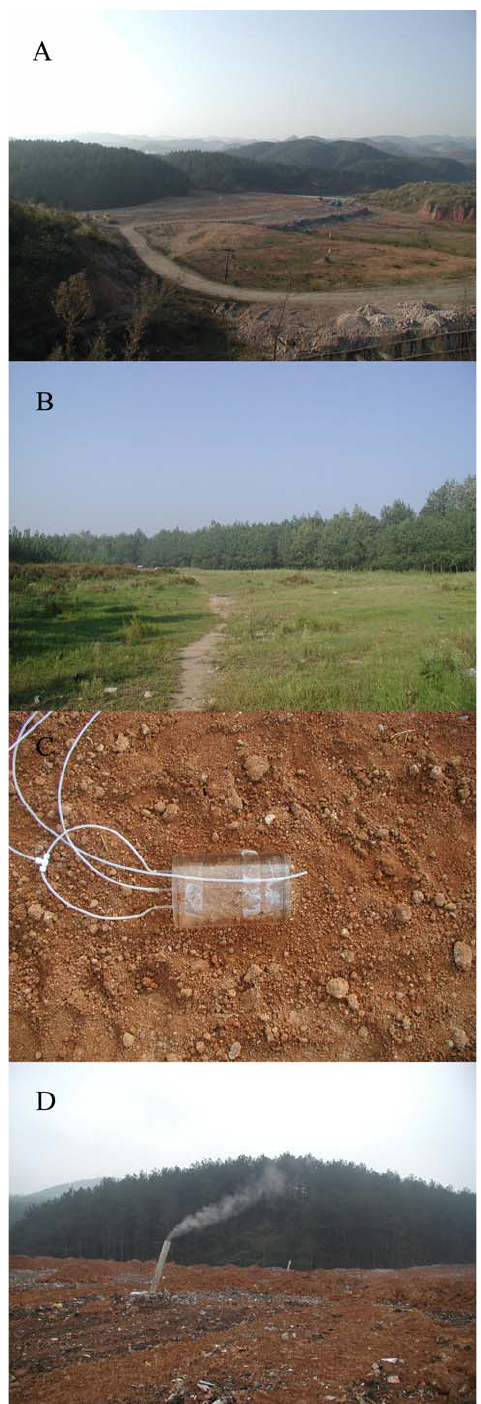
Fig. 2. Photos showing the operation landfill at G-Y (A) and closed landfill at X-R-J (B) , the DFC method for surface-air flux at the soil covering area (C) and the vent pipe system for the LFG at G-Y landfill (D)